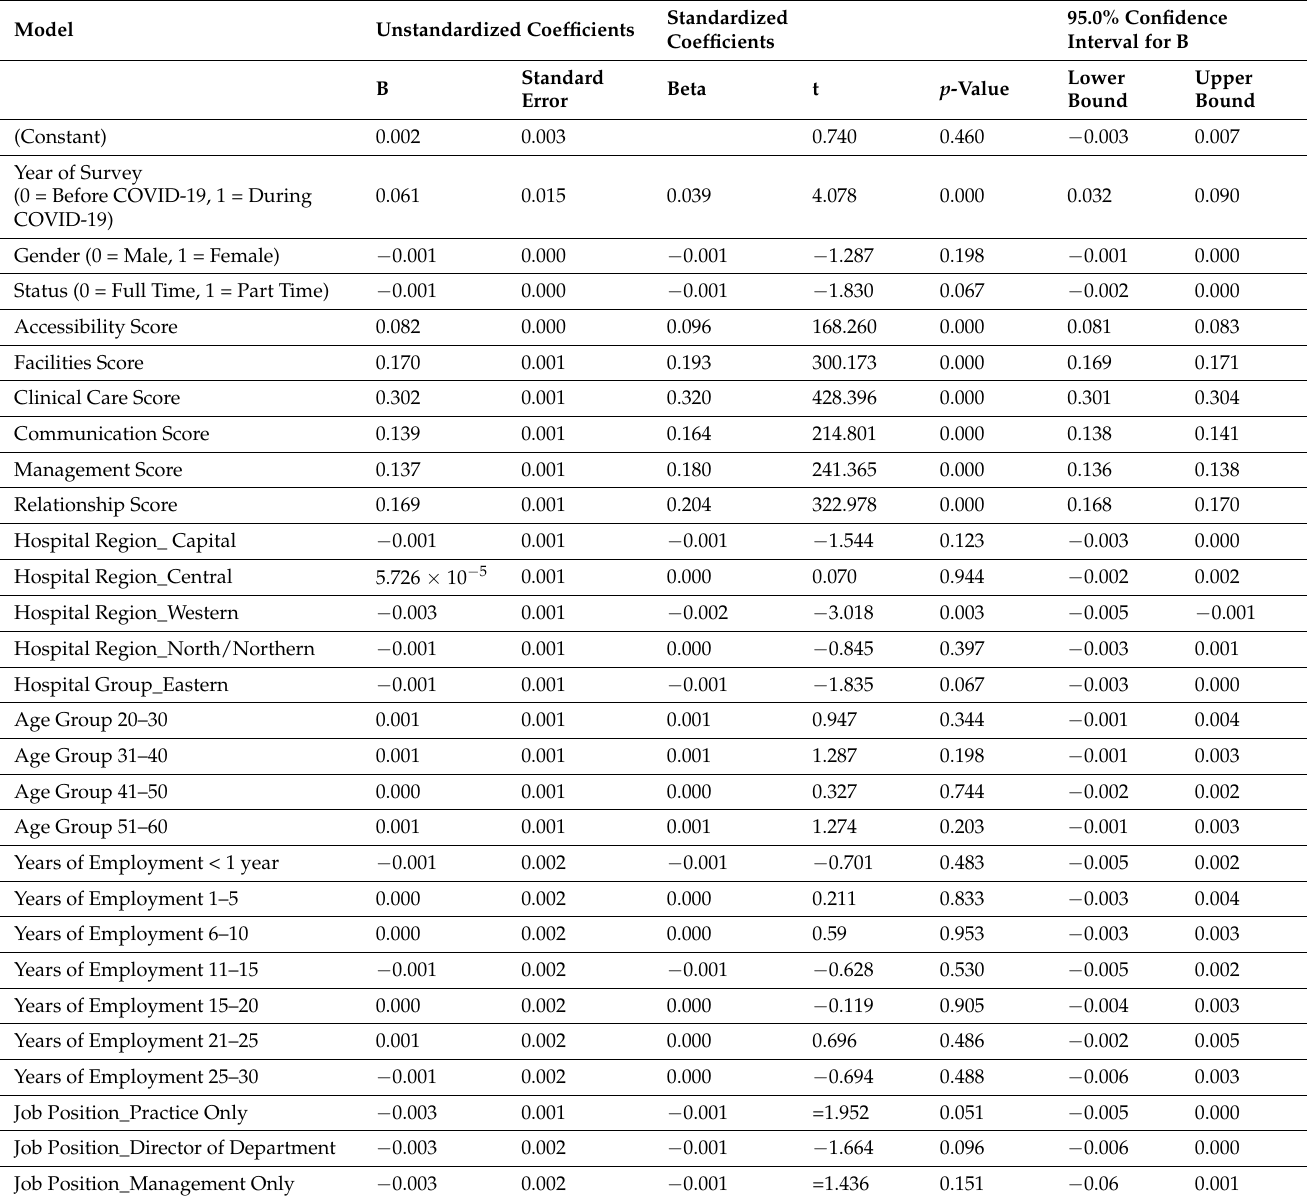
Table 3. Multiple linear regression analysis to predict physician engagement based on the factors